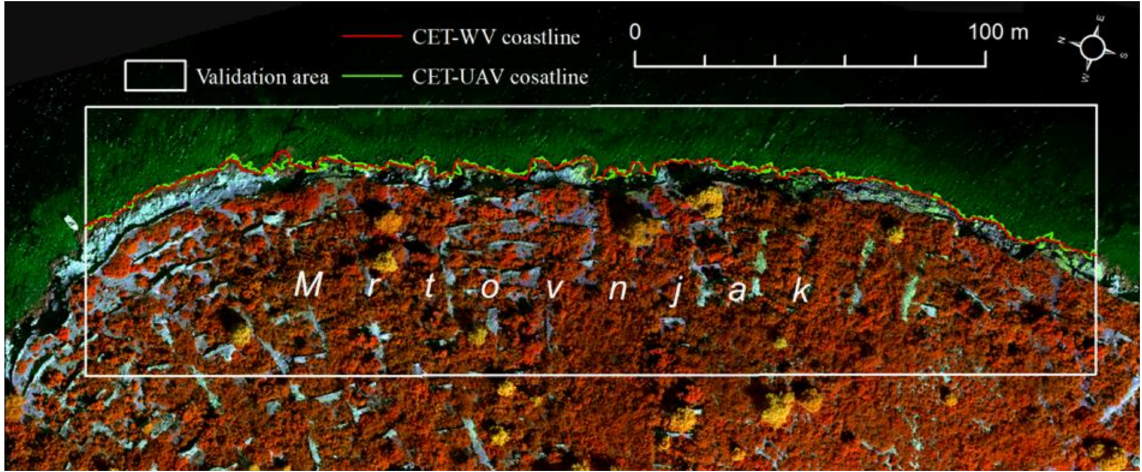
Figure 10. Coastlines within validation area derived by CET from WV-derived (red) and UAV-derived (green)